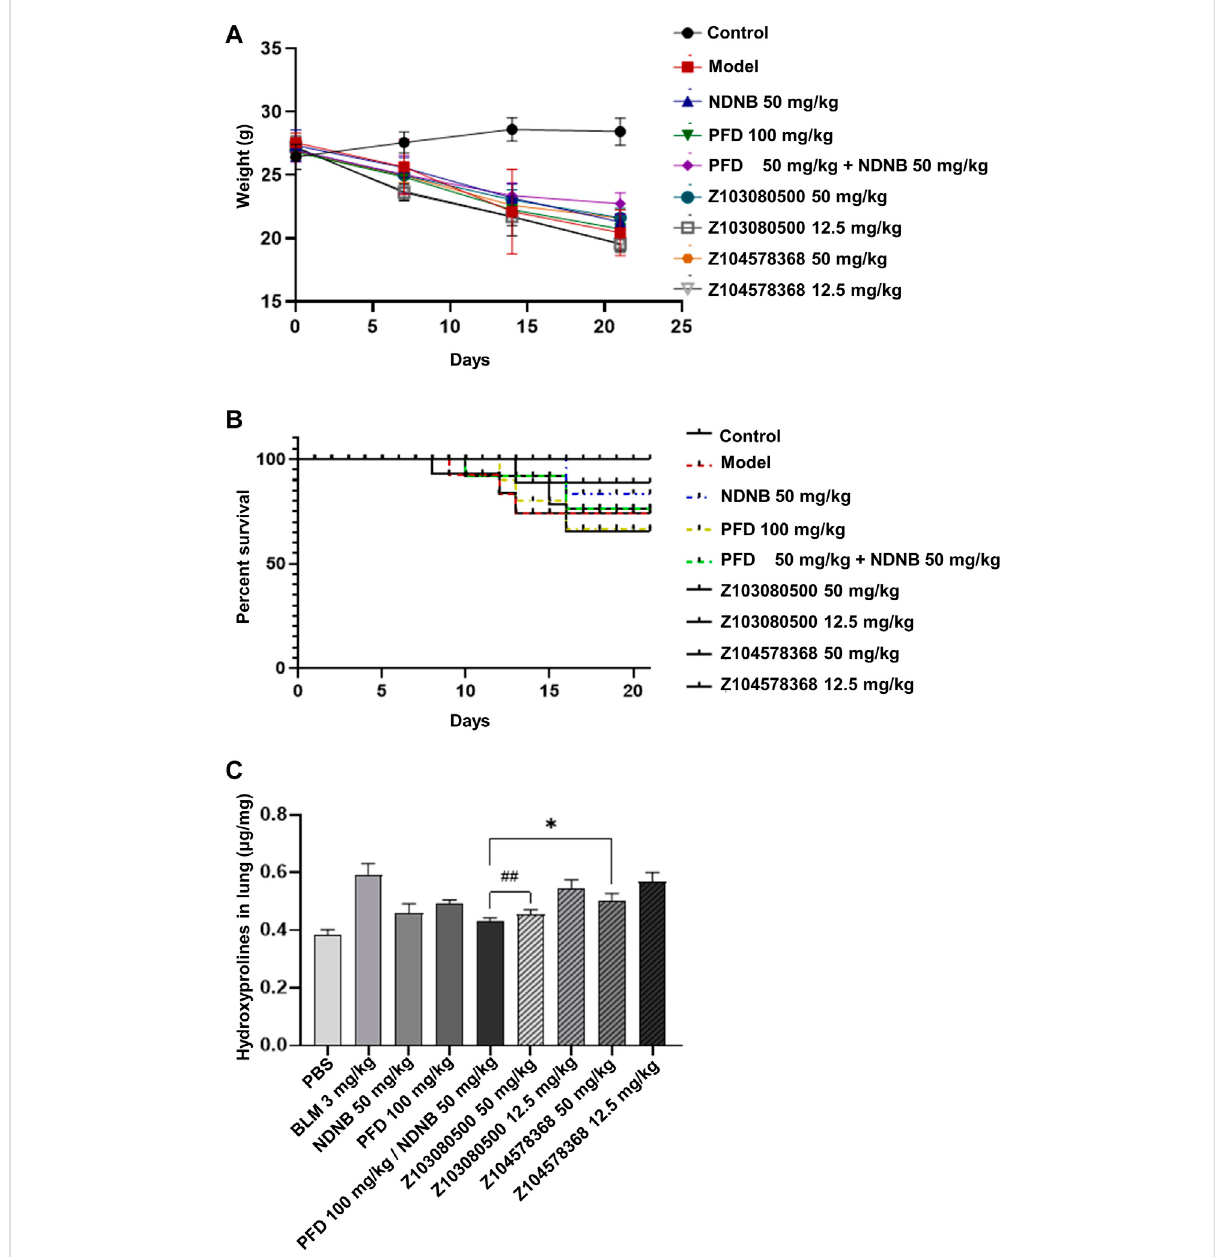
FIGURE 7 Body weight change, survival, and biomarker expression. Changes in body weight (A) and survival (B) of BLM mice throughout the experiment. (C) The expression of Hyp in BLM mice (N = 6-7 each group). Doses and groups have been marked on the abscissa. All experiments were performed in triplicate independently. BLM: BLM. NDNB: NDNB. PFD: PFD. Hyp: